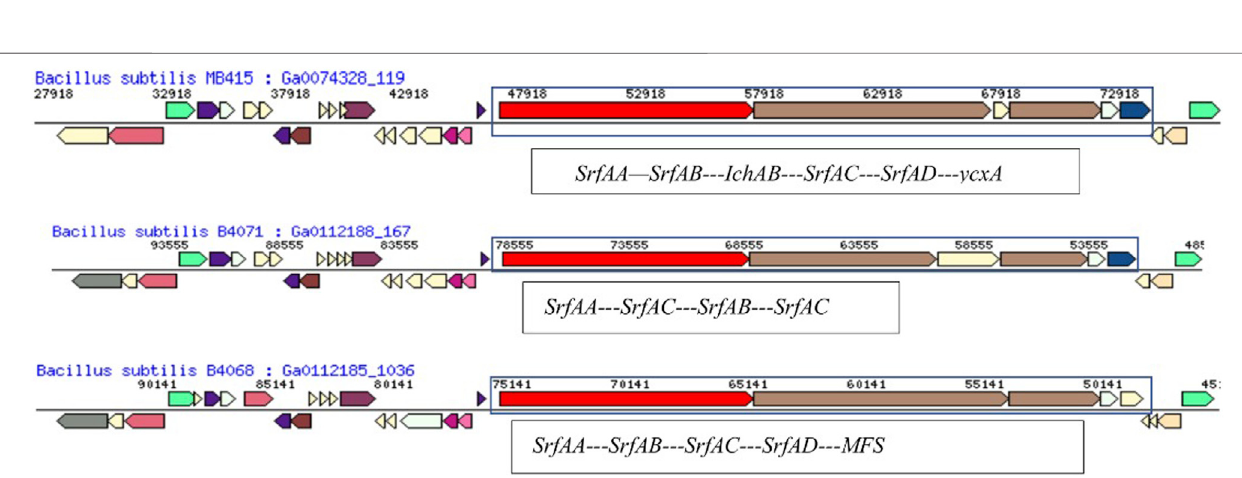
Frontiers in Bioengineering and Biotechnology |